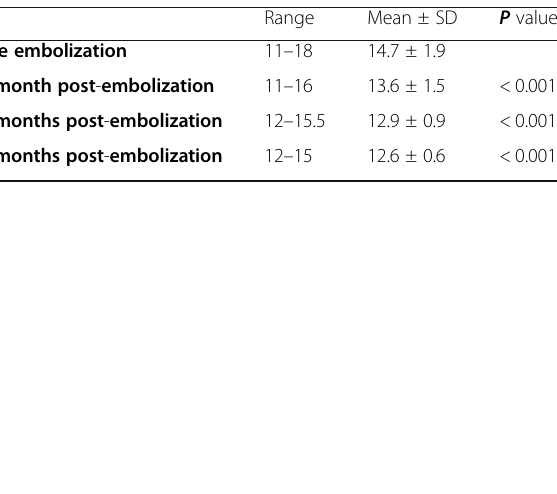
Table 7 PV diameter pre- and post-embolization PV diameter before and after embolization (mm)